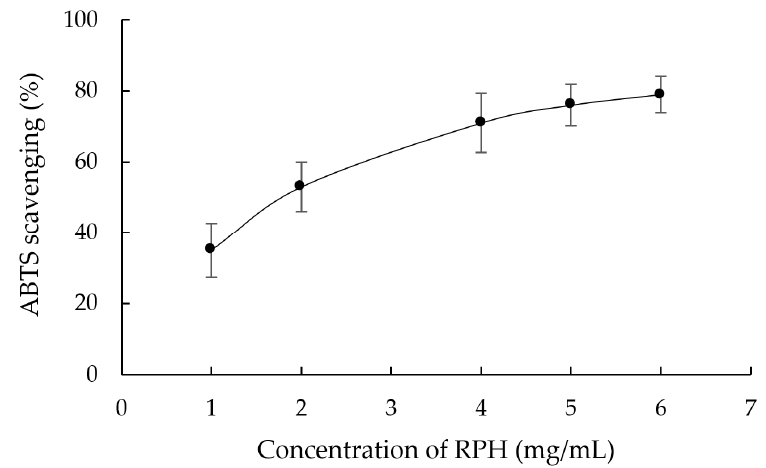
Figure 3. Influence of RPH concentration on the scavenging ability of 2,2 ′ -azino-bis(3- ethylbenzothiazoline-6-sulfonic acid) (ABTS).